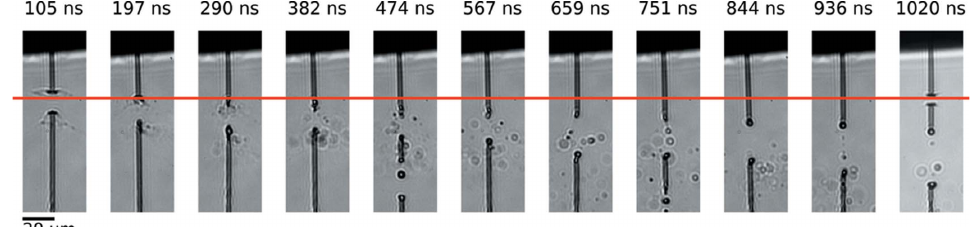
Figure 5 Sideview images showing the arrival of the second X-ray pulse in a train of pulses. The water jet was operated under the same conditions described in Fig. 4. The horizontal red line indicates that the jet has recovered and is stable in the X-ray interaction region after <290 ns. The last image in the sequence shows the jet after being hit by the second pulse in the pulse train. The scale bar is 20 m m. X-rays are incident from the